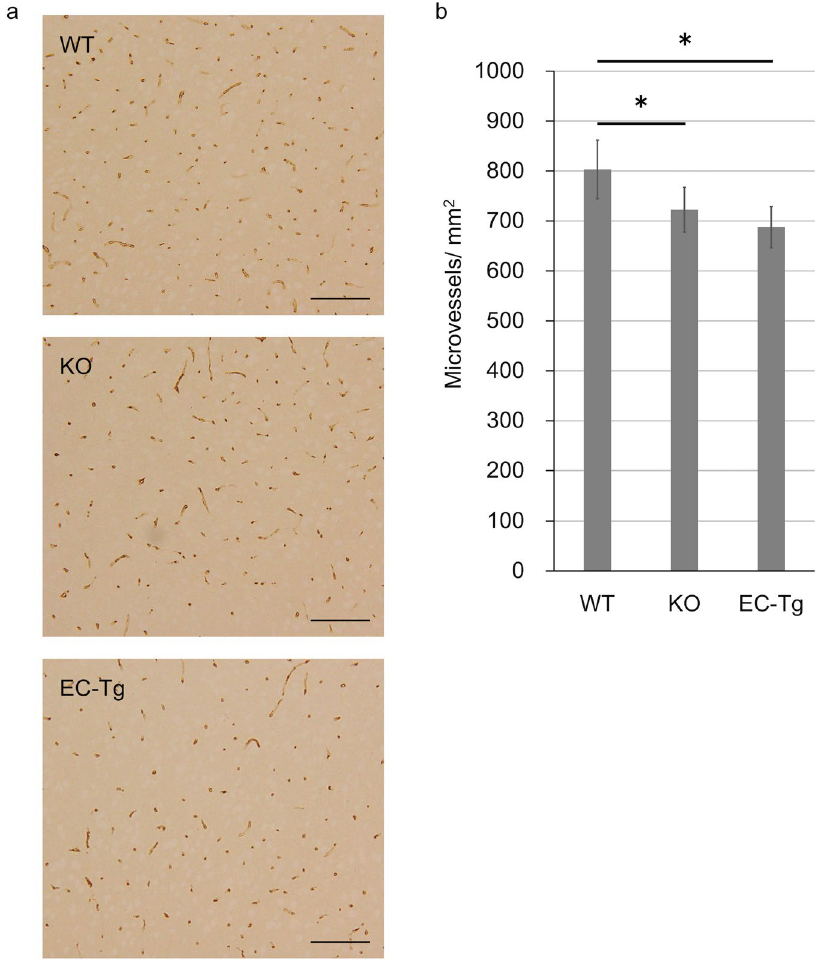
Figure 4. Cerebral cortex stained for glucose transporter 1 (Glut1) of surviving mice. ( a ) Representative images of Glut1-immunostained sections of cerebral cortex of WT, KO and EC-Tg mice at 28 days after BCAS. Scale bar represents 100 μ m. ( b ) Quantified results of cerebral microvessels. A column with a bar represents mean ± SD of the number of cerebral microvessels/mm 2 . There was a significant difference in the number of cerebral microvessels between the three genotypes using one-way ANOVA (WT, n = 6; KO, n = 5; EC-Tg, n = 8; p = 0.002). There were significant differences between KO and WT ( p = 0.034) and between EC-Tg and WT ( p = 0.001) using Tukey’s test; * p < 0.05 vs